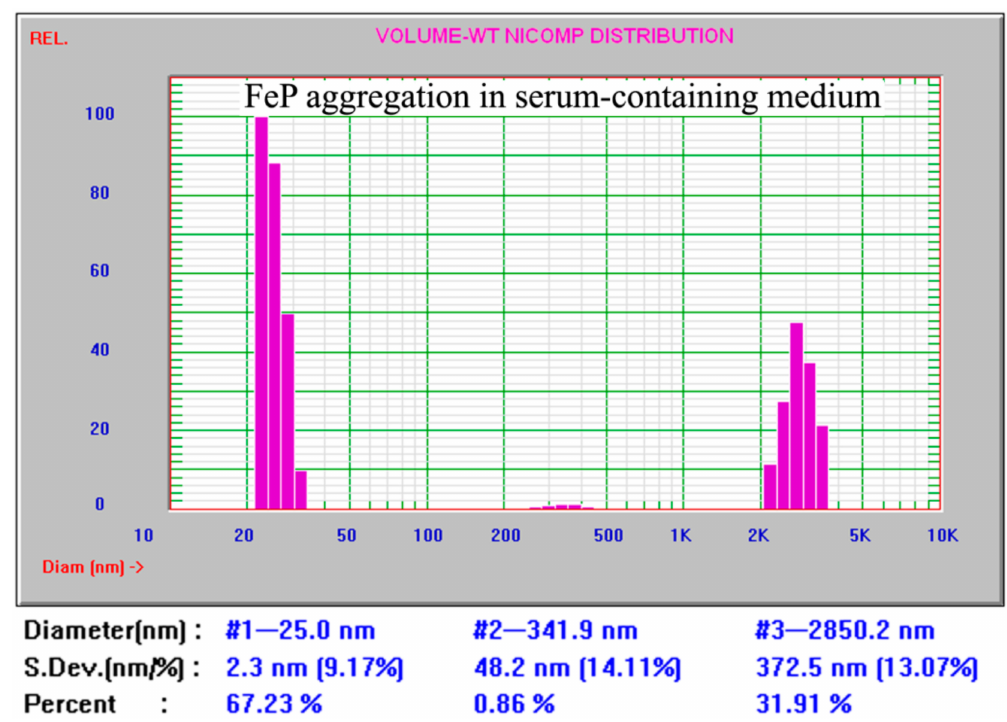
Figure A3. Nicomp particle size distribution of Fe-PEI aggregates shaped by 24 h culture in DMEM (Dulbecco’s Modified Eagle Medium) in the presence of 10% FCS. Note that a smaller number of NPs are assembled into aggregates of 2.85 ± 0.37 µ m, larger than those obtained in serum-free medium.